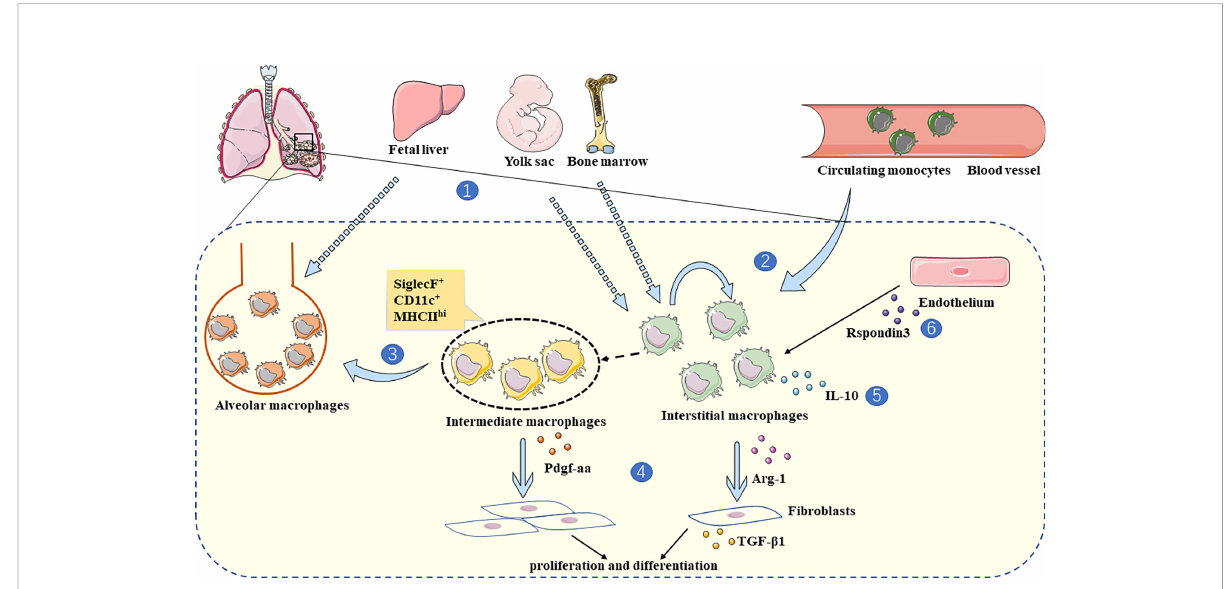
FIGURE 1 The role of IMs in lung fi brosis. 1. IMs are derived from BMDM and yolk-sac (24, 34), while AMs are mainly derived from fetal liver (33). 2. IMs are replenished by circulating monocytes and self-renewal (24, 31). 3. Due to computational trajectory tracking analysis, monocytes tend to transform into IMs during steady-state (31), and intermediate macrophages with monocytic origin (SiglecF + CD11c + MHCII hi ) convert to AMs in fi brotic lungs (46). 4. In a state of lung fi brosis, IMs produce Arg-1 and interact with fi broblasts directly, which stimulates fi broblasts to produce TGF- b 1 (66). In addition, intermediate macrophages (SiglecF + CD11c + MHCII hi ) secrete Pdgf-aa, promoting fi broblast proliferation and differentiation (46). 5. The major IL-10 producing IMs (lyve hi MHCII lo ) alleviate lung fi brosis (24). 6. At the in fl ammatory stage of bleomycin induced lung fi brosis, Rspondin3 secreted by endothelium can promote the IMs expansion